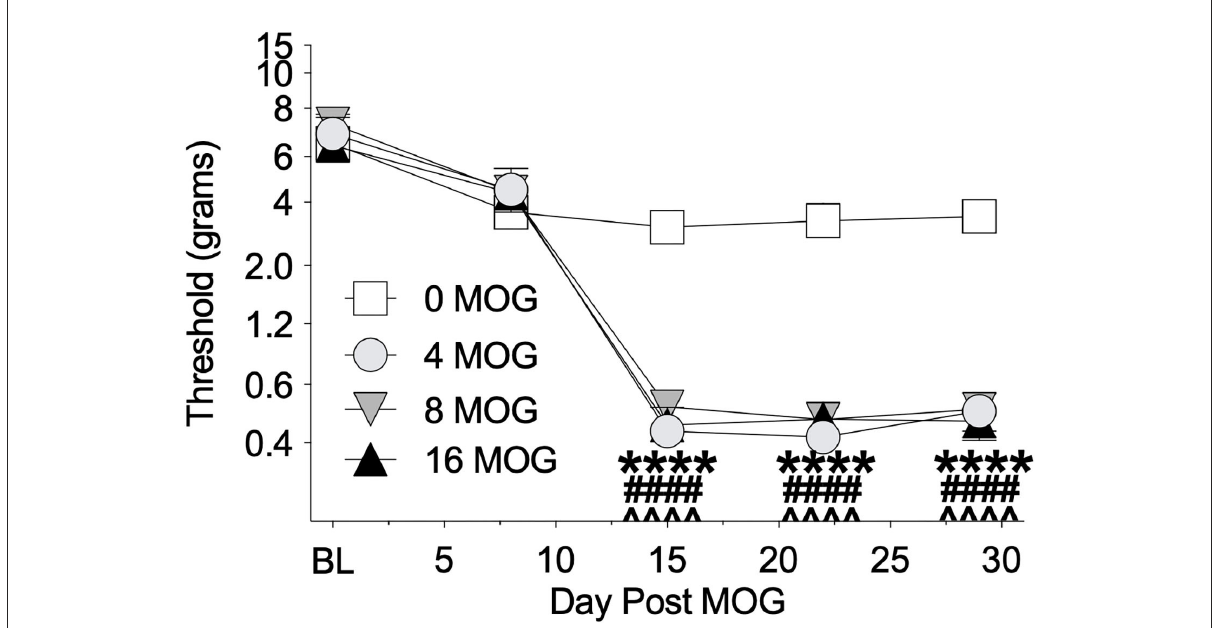
FIGURE2 Myelin oligodendrocyte glycoprotein (MOG) in Sprague-Dawley (SD) rats produces full mechanical allodynia at all doses tested. Sprague-Dawley (SD) rats were baselined (BL) for mechanical withdrawal thresholds via the von Frey test, followed by intradermal low-dose (0, 4, 8, and 16 µ g) myelin oligodendrocyte glycoprotein (MOG). Allodynia was assessed thereafter across the timecourse shown, continuing through day 30. All doses of MOG induced full mechanical allodynia by day 15, which lasted through day 29. Main effects of day [ F (4, 64) = 161.3; p < 0.0001], MOG dose [ F (3, 16) = 29.83; p < 0.0001], and interaction between day and MOG dose [ F (12, 64) = 10.8; p < 0.0001]. N = 5/group. Post-hocs : **** indicates significant differences between 0 µ g MOG control and 4 µ g MOG, #### indicates significant differences between 0 µ g MOG control and 8 µ g MOG, ∧∧∧∧ indicates significant differences between 0 µ g MOG control and 16 µ g MOG.